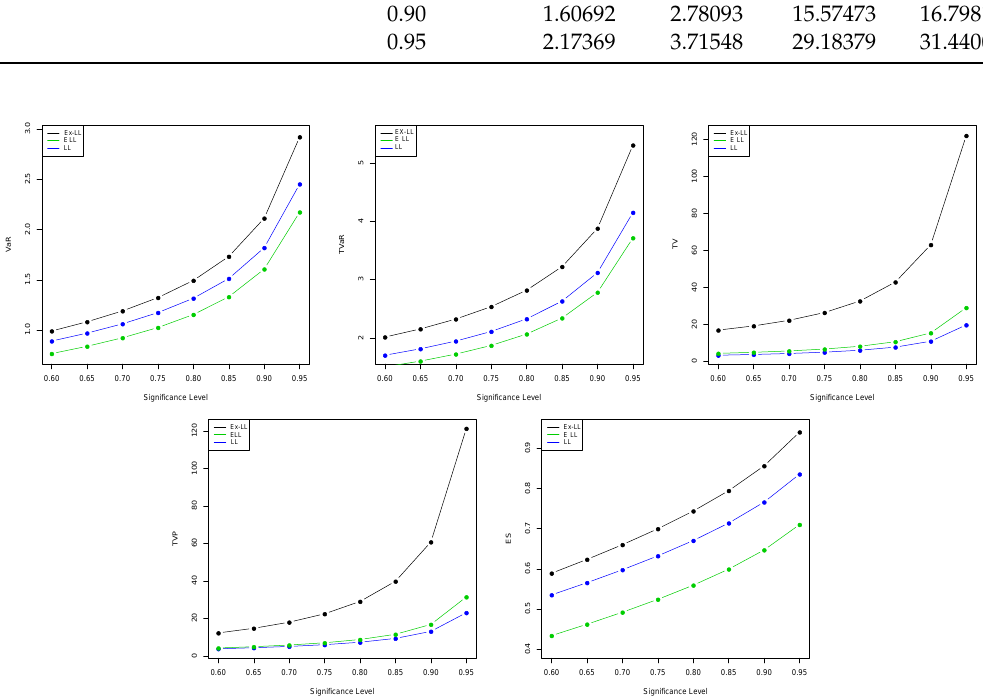
Figure 3. Shapes of the VaR, TVaR, TV, TVP, and ES using the numerical values in Table